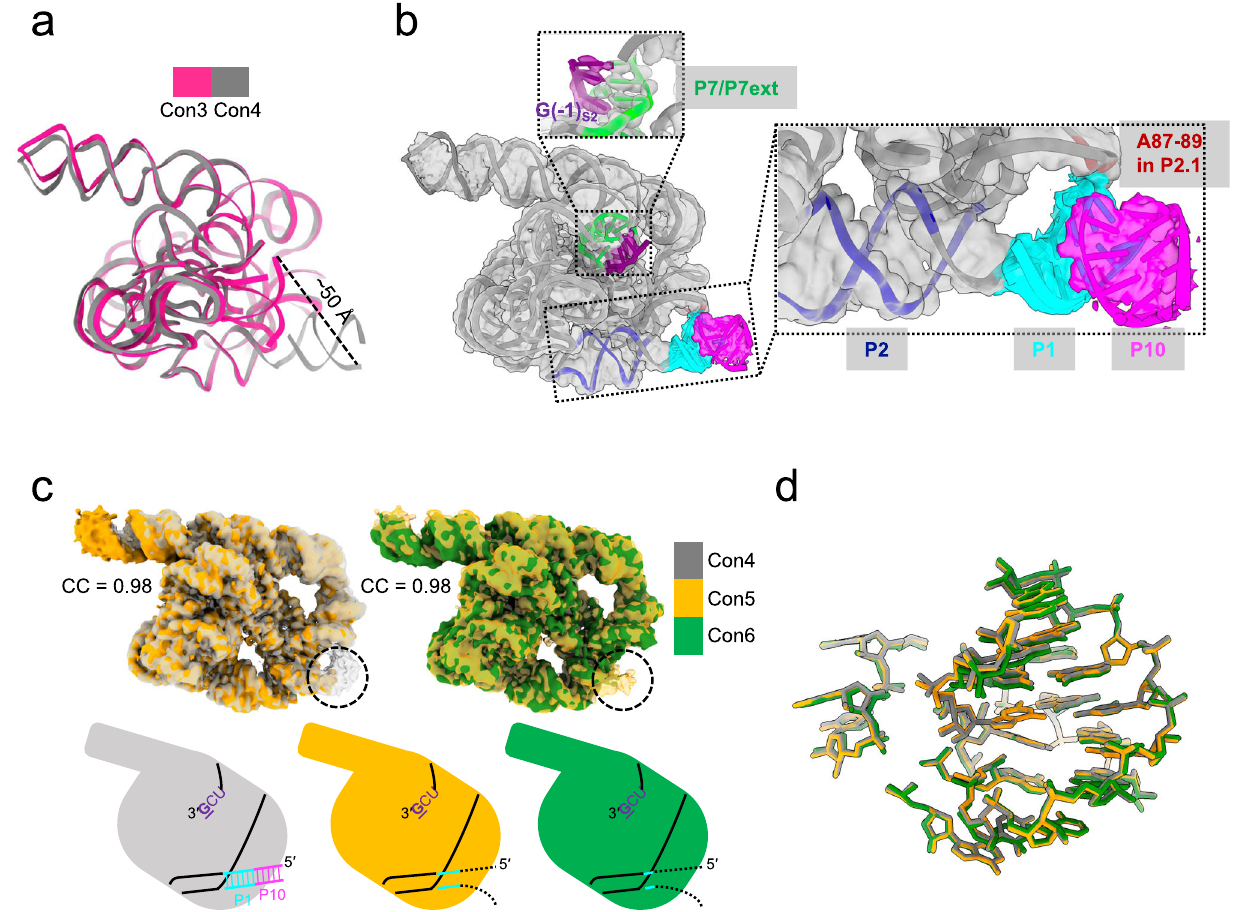
Fig. 4 | Structural features of Tetrahymena ribozyme in Con4-6. a The P1-P10 duplex undergoes a large conformational change in Con4 compared with Con3. b P1-P10 iscoaxially stacked with P2 and contacts with P2.1, while the P7 extension remainsunchanged. c SuperpositionsofCon4and5,aswellasCon5and6cryo-EM maps, reveal an unpairing process. Black dotted circles indicate undocked helical